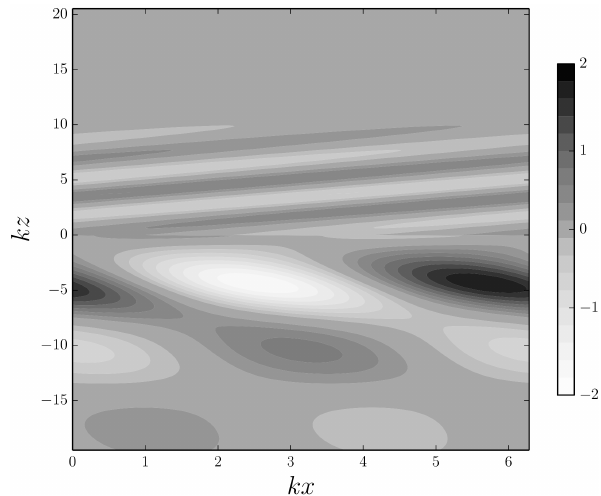
Figure 9. Contours of vertical velocity at τ ≈ 0 in two layers. The parameter values are n 1 /k = 0.4, N 2 /N 1 = 2, (cid:15) = 0.025, and α =